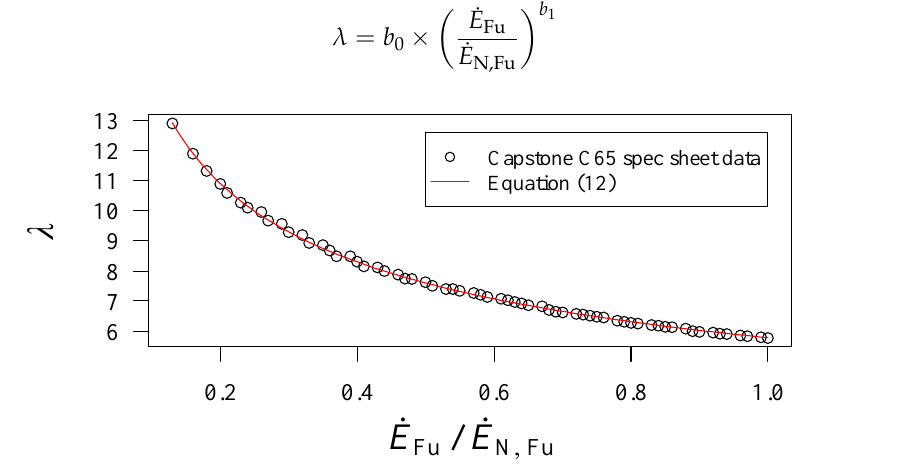
Figure 4. Air ratio vs. fuel capacity percentage of Capstone C65 MGT at ISO conditions. The S of the curve fit is 0.049 on 62 degrees of